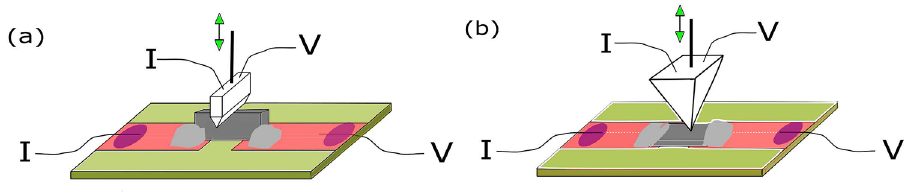
Figure 1. Schemes of the point-contacts forming the four-probe electric connections for I − V measurements in a microwave field P . FeBS single-crystal plate was clamped by In on a foiled glass-fiber plastic substrate. The movable PbIn S electrode was soldered to copper wire and was pressed to the FeBS plate. A probe current I is injected into the PC and the voltage drop V across the contact is measured. The microwave signal was supplied by a cable. ( a ) Scheme of the PC with current injection along ab plane. ( b ) PC with current injection along c axis.